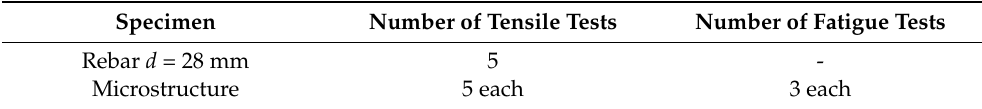
Figure 3. Specimen distribution over the cross-section containing the different depths and diameters of the cylindrical microstructure specimens ( left ), and cross-section of the whole rebar after eroding the microstructure specimens ( right ) . Table 2. Test matrix of the experimental program.